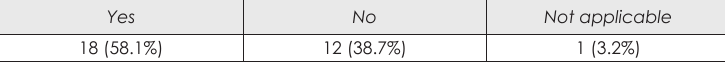
Table 12: Membership of MBA (n=31)